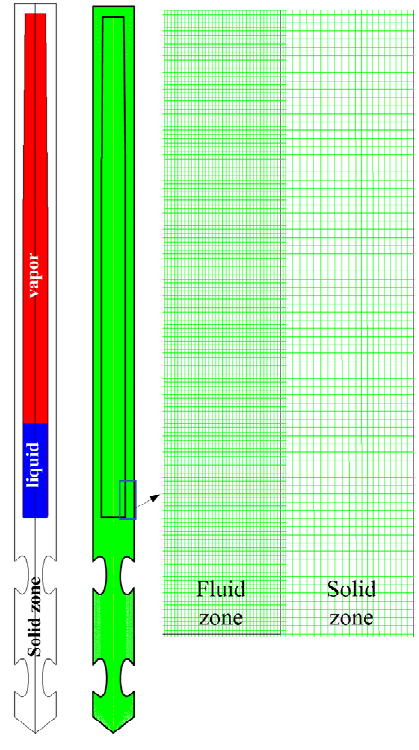
Figure 4. Simulation model for RHPD.